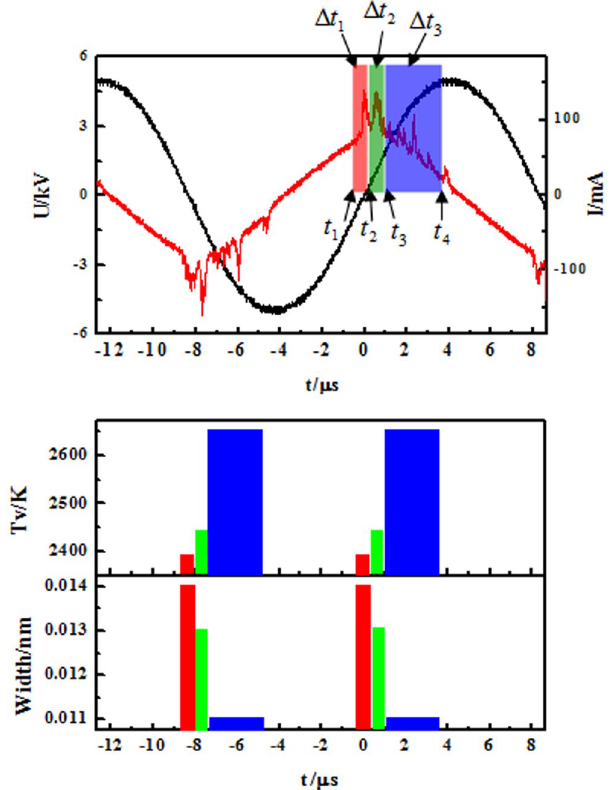
Figure 6. The spatiotemporally resolved plasma parameters of the complex pattern with hexagonal lattice and white-eye